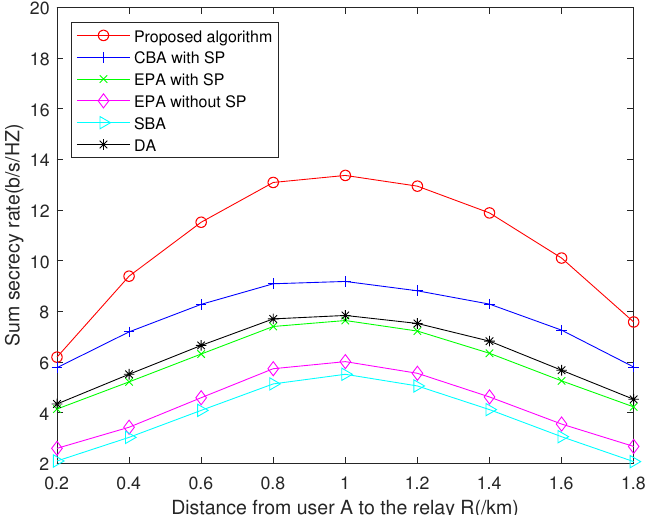
Figure 6. Sum secrecy rate versus distance from user A to the relay R when N = 16 and transmit power per node is 20